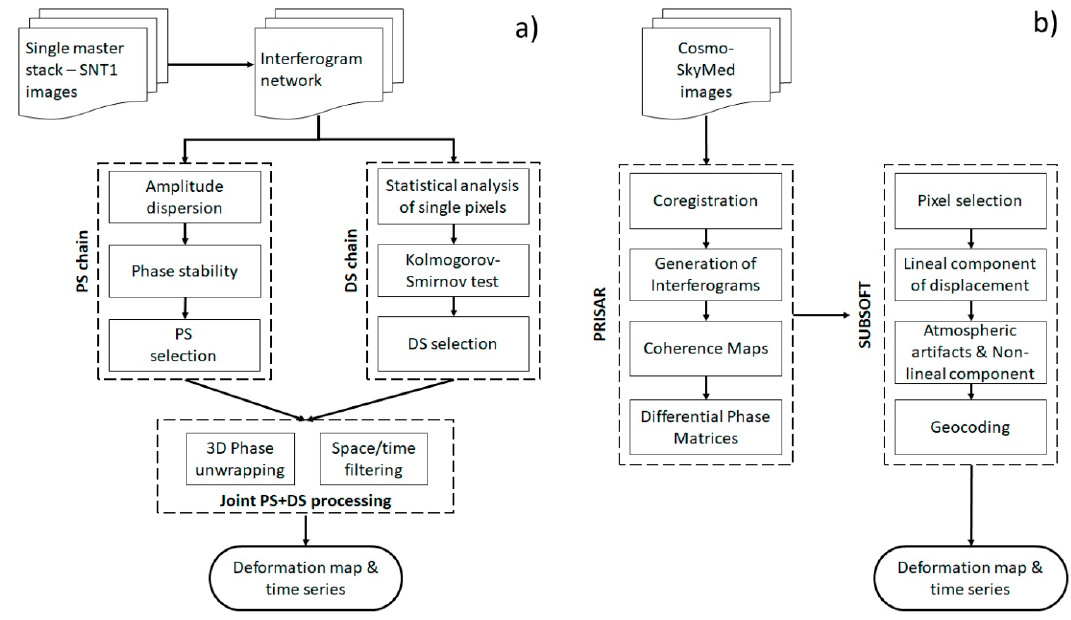
Figure A1. SqueeSAR ( a ) and coherence pixel technique (CPT) ( b ) processing workflows.